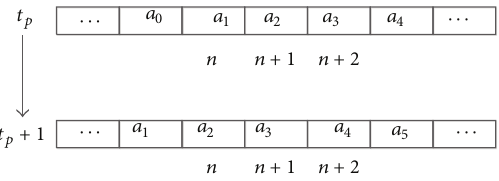
Figure 14: Chart of one-dimensional cellular movement at the entrance and